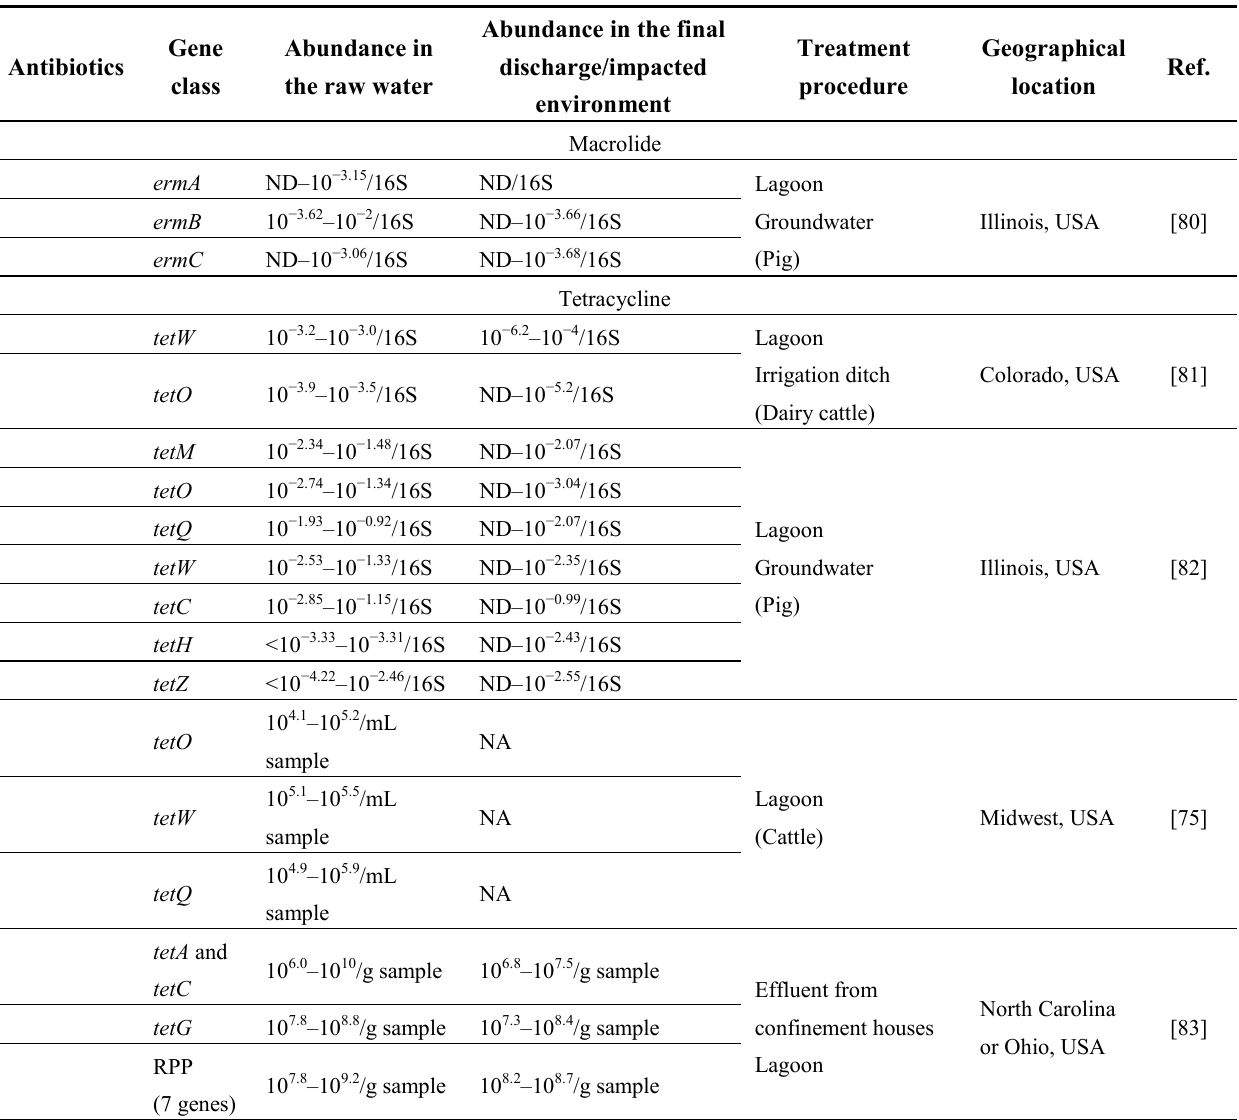
Table 3. Abundance of antibiotic resistance genes present in livestock production lagoons and treated manure. Abundance was determined by quantitative